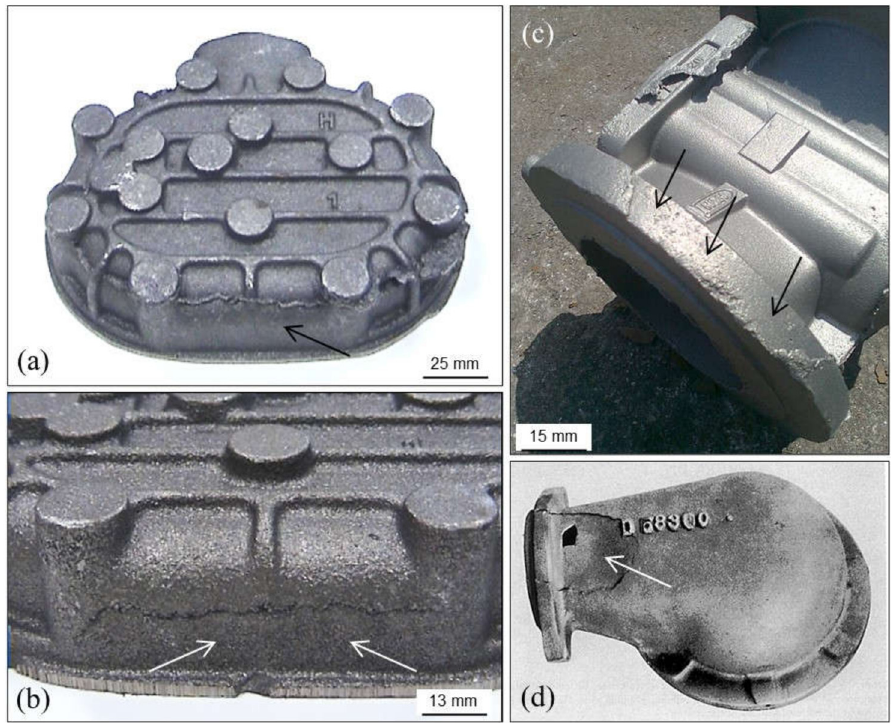
Figure 44. Iron castings with areas affected by mold sinking: ( a , b ) ductile iron covers with sunken areas close to the partition line; ( c ) a ductile iron valve with the defect affecting one of the flanges; ( d ) a cast iron part showing the defect (Reprinted with permission from ref. [17]. Copyright 1999 American Foundry Society, page